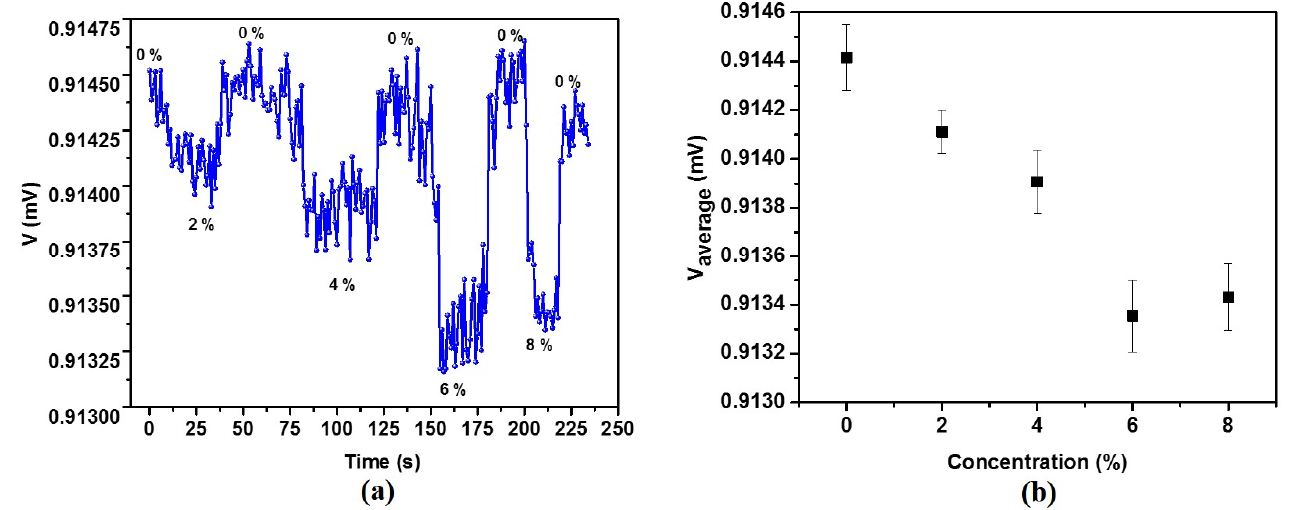
Figure 8. ( a ) Variation in the sensor output voltage in time for different particle concentrations; ( b ) the average value of the output voltages as a function of particle concentration.